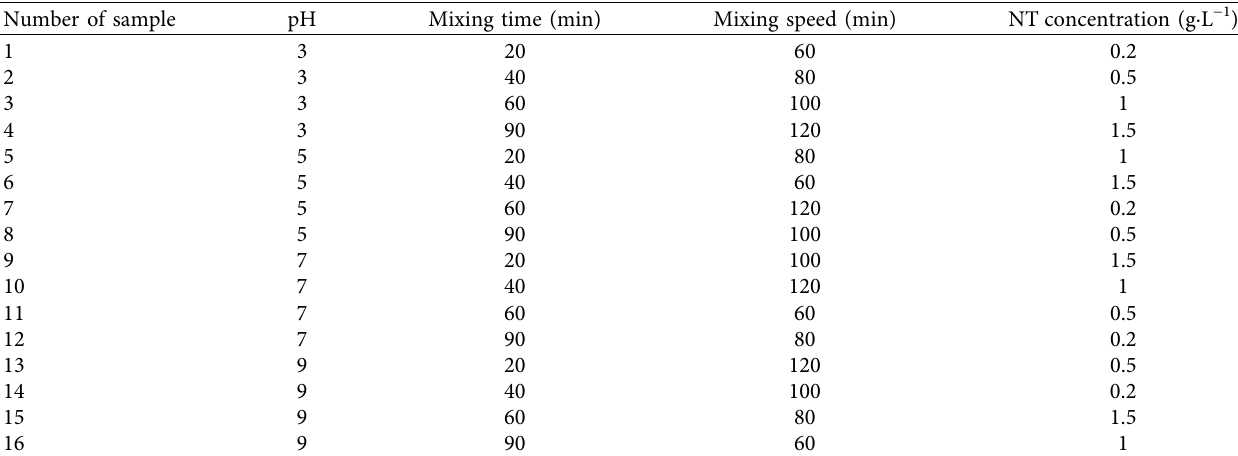
Table 2: Experimental variables according to the Taguchi